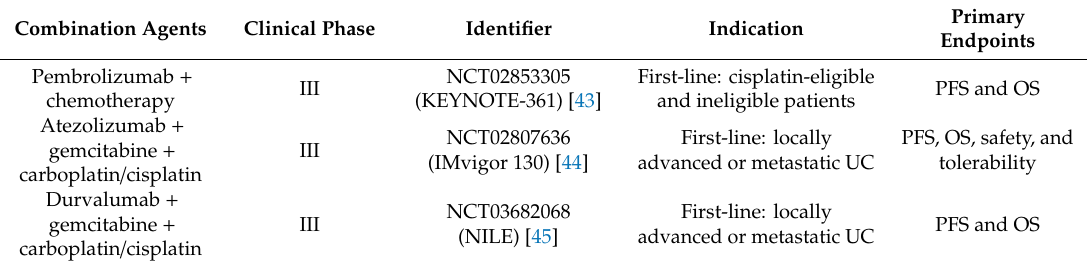
Table 3. Ongoing trials evaluating a combination of chemotherapy and immunotherapy for urothelial